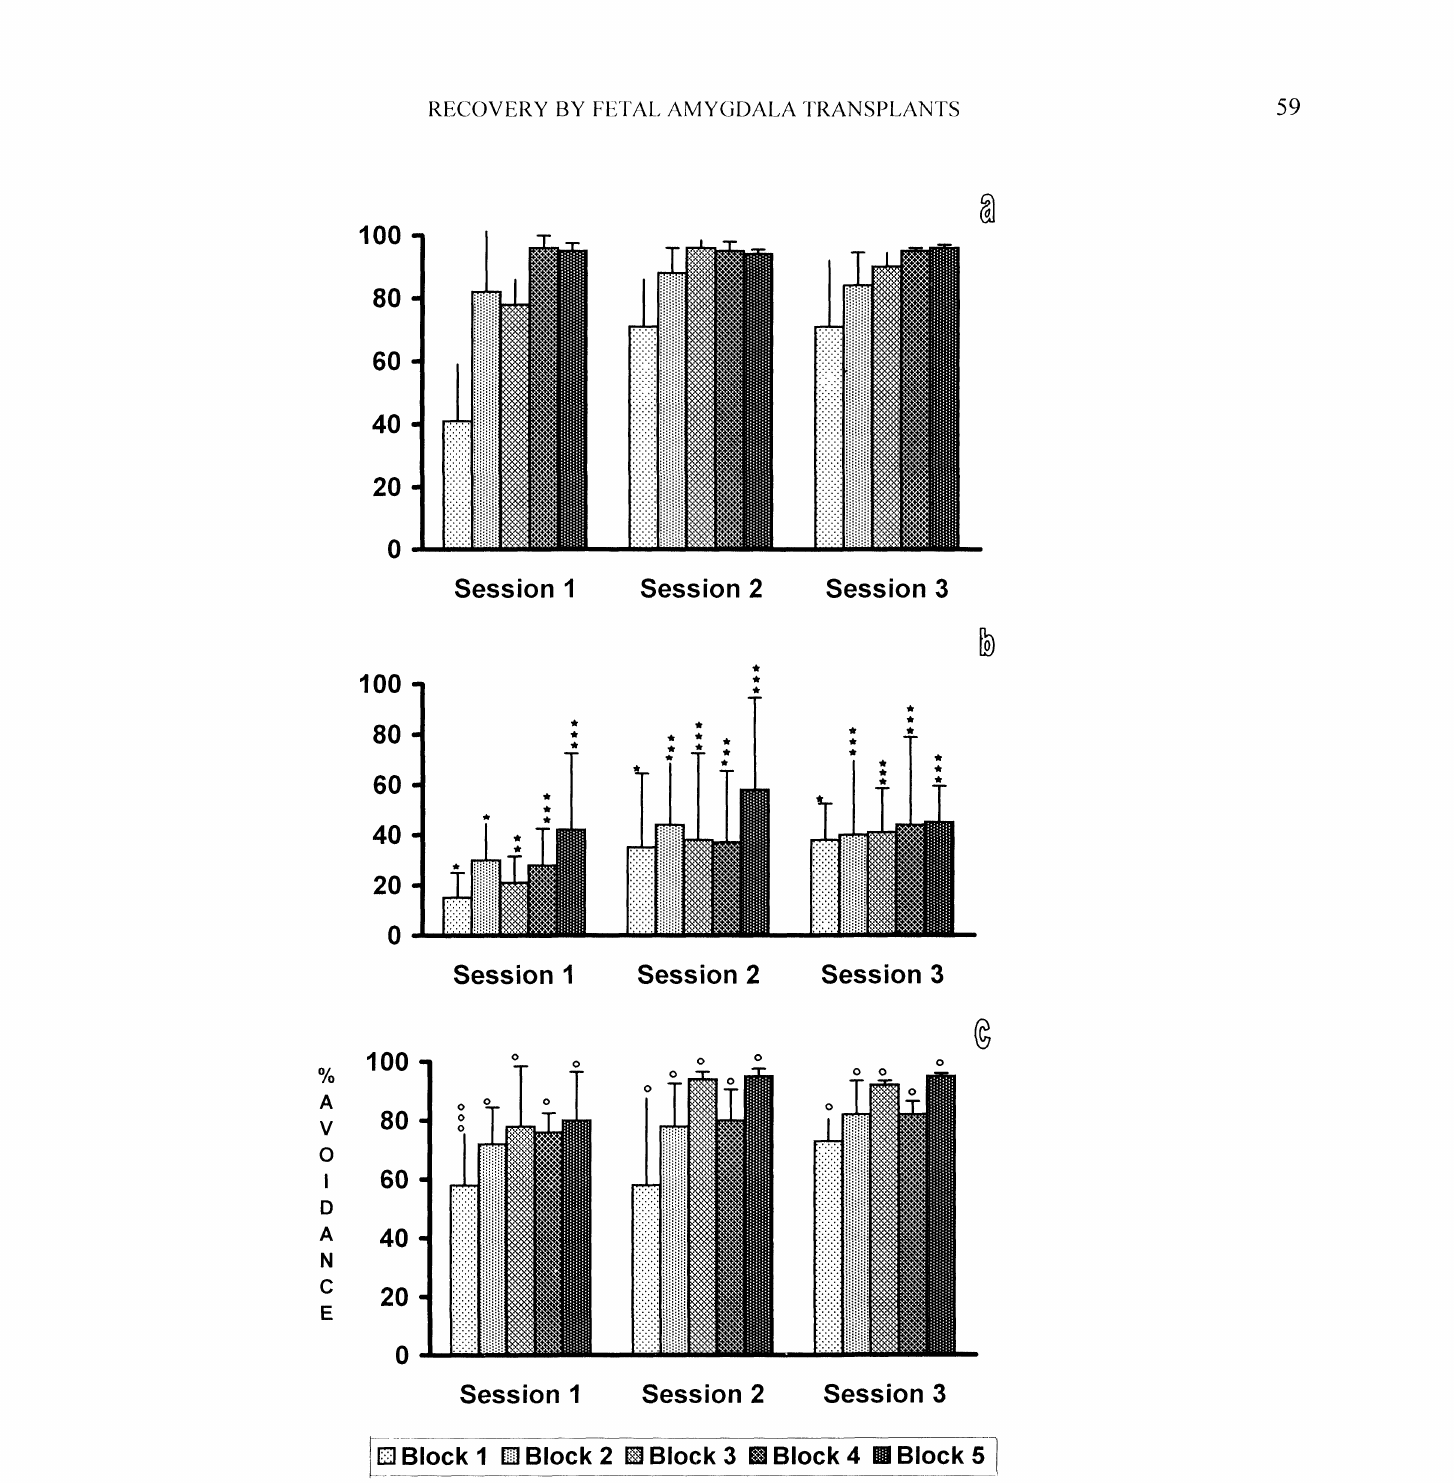
Fig. 2: Effect of sham operation (a), CeA lesion (b) and CeA lesion-transplant (c) on the percentage of avoidance (Mean+S.D.) in the three sessions given on alternate days. The POA in each block of group Ill is compared with the corresponding block of groups II and and that of group II is compared with group I. * indicates comparison of POA of groups II and IIl with group I, *** p<0.001, ** p<0.01, * p<0.05. indicates comparison of POA of group III with group II, o== p<0.001, p<0.01, p<0.05. The intergroup comparisons were made by using Kruskal Wallis and Multiple Range